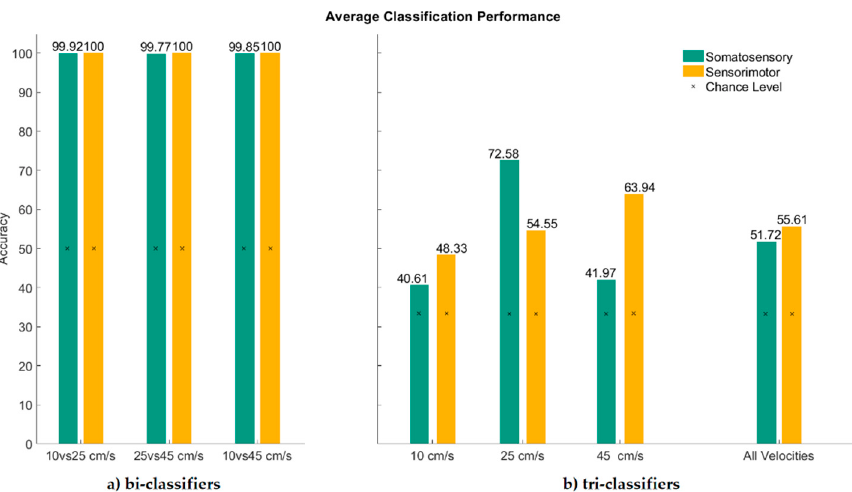
Figure 3. Average classification performance in bi- and tri-classifiers in the passive (green) and active (yellow) tasks, across 11 participants. ( a ) three bi-classifiers performing almost perfectly (accuracy > 99%). ( b ) three tri-classifiers and their average result.